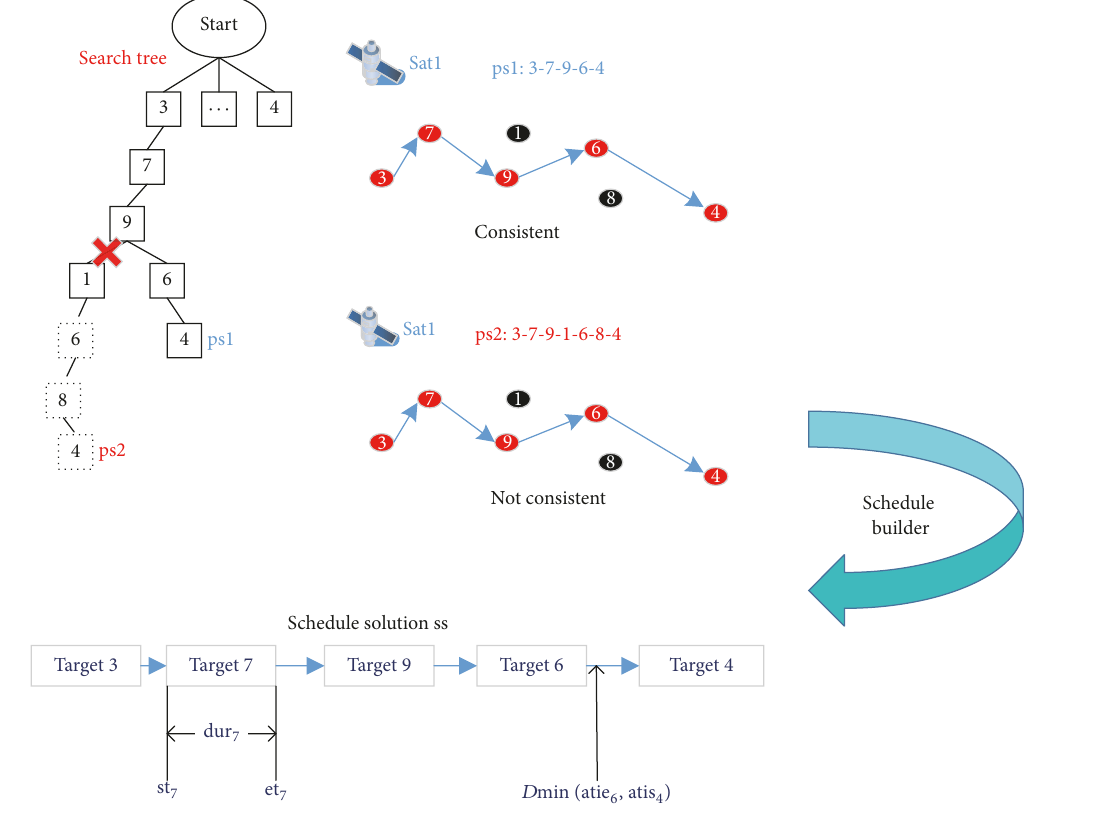
Figure 4: Sequence solution and scheduling